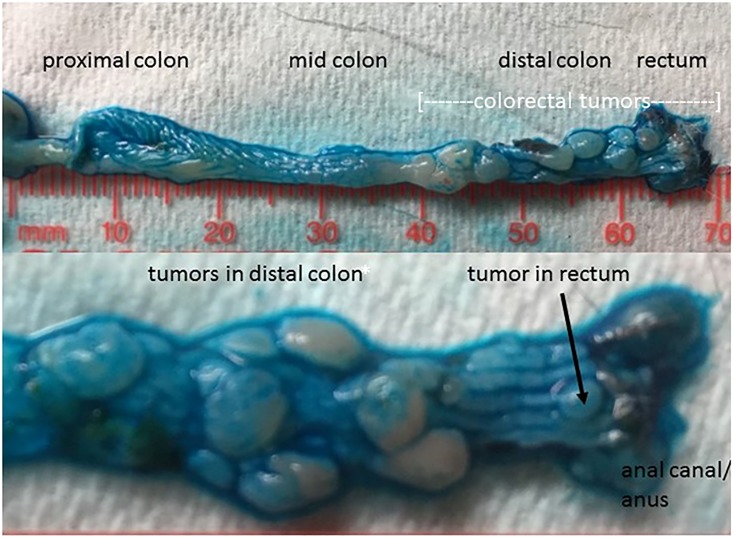
Macroscopic visualization of tumors in Hltf-deleted colon.Alcian blue (1%) was topically applied to longitudinally opened colons from two different Hltf-deleted mice to highlight the borders of the individual tumors against the normal epithelium of the colon (upper panel) and each other (lower panel). The heterogeneity of the tumor burden in the distal colon/rectum is well demarcated by the Alcian blue stain.